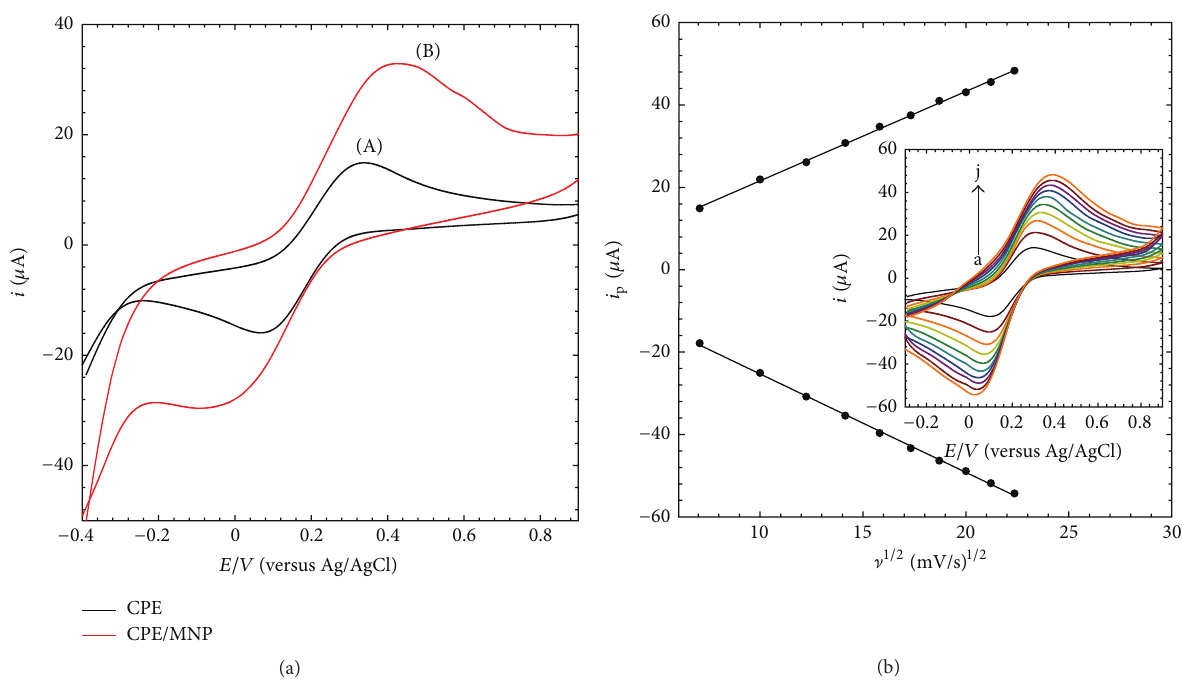
Figure 2: (a) The cyclic voltammograms of (A) the MCPE and (B) the MCPE/MNP in a solution of 0.1M NaClO 4 containing 0.5mM and square root of scan rate ( ] 1/2 ) at the MCPE/MNP. Inset is the cyclic volta- [Fe(CN) 6 ] 3−/4− , scan rate 100mVs −1 . (b) Linear relationship of 𝑖 p mmograms of the MCPE/MNP in a solution of 0.1M NaClO 4 containing 0.5 mM [Fe(CN) 6 ] 3−/4− with different scan rates ((a)–(j): 50, 100, 150, 200, 250, 300, 350, 400, 450, and 500 mVs −1